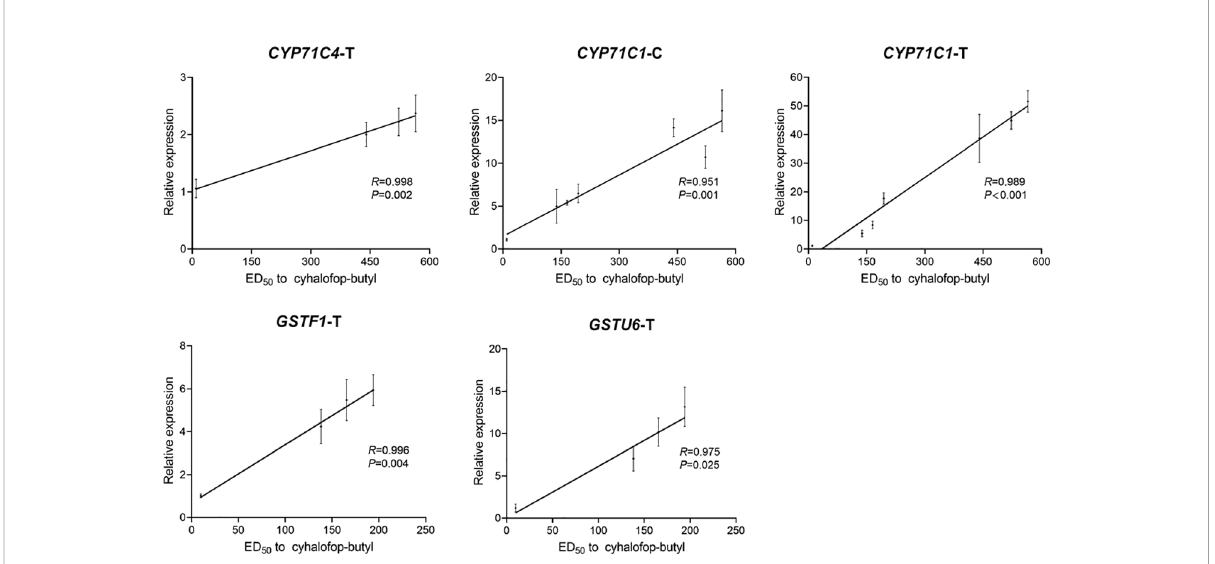
FIGURE 6 Correlations between the relative expression levels of candidate genes and cyhalofop-butyl resistance levels in F 1 groups. For the untreated groups, the gene is CYP71C1 -C. For the cyhalofop-butyl-treated groups, the genes are CYP71C4 -T, CYP71C1 -T, GSTF1 -T, and GSTU6 -T. Pairwise correlations between gene expression and cyhalofop-butyl ED 50 were determined by Pearson ’ s correlation analysis in SPSS v. 20.0. Relative expression levels shown on the Y-axis were evaluated by the 2 - △△ Ct method. They represent the ratios of the normalized expression levels of the candidate genes in the corresponding group to those of the same genes in the LC-S-F 1 group. The ED 50 values for cyhalofop-butyl are shown on the X-axis. Error bars indicate the standard error of the mean for three independent